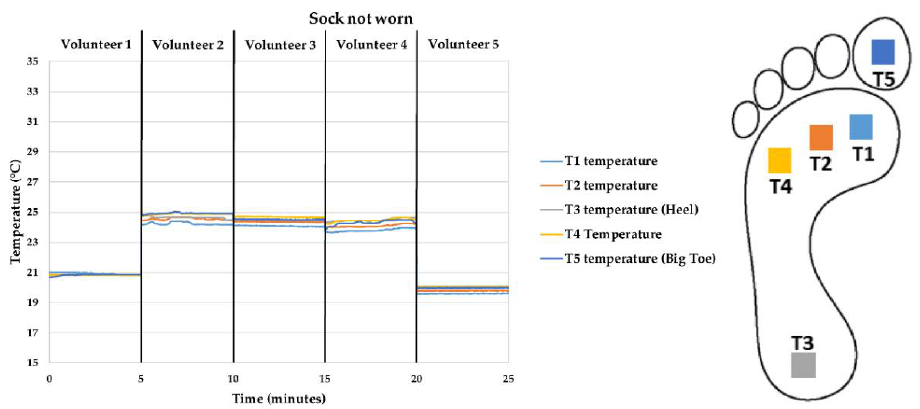
Figure 8. Temperature measurements from the temperature sensing sock when the sock was not worn by a volunteer. Temperatures were recorded prior to testing on all the volunteers.